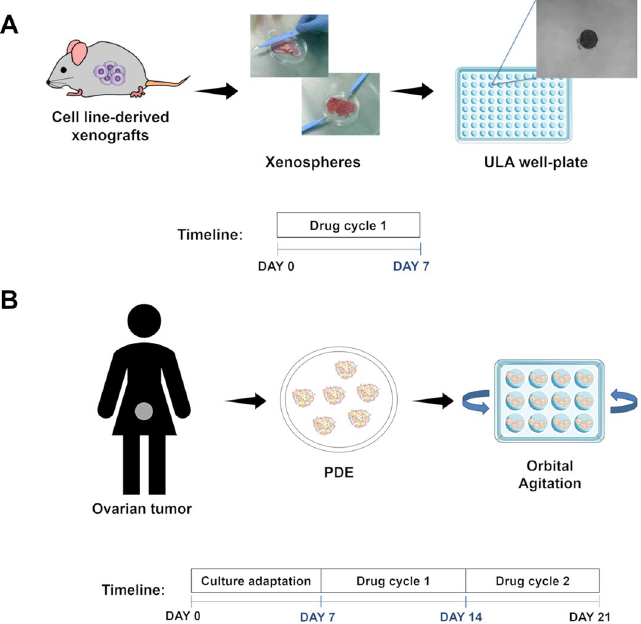
Figure 3. Schematic representation of the culture generation and drug cycle strategy pursued for ex vivo cultures. ( A ) Mouse xenografts are mechanically dissociated to form xenosphere explants. Individual xenospheres are cultured in a single well of a 96-well ultra-low attachment (ULA) plate. Docetaxel (DTX) treatments of 0.1, 5, 25, 125, 625, and 3125 nM are added directly to the xenospheres on the day of culture generation. Cell death in xenosphere cultures is assessed on day 7 by LDH assay. ( B ) Surgical-resected ovarian tumor specimens are mechanically dissociated into fragments, named patient-derived explants (PDE) and cultured in 12-well plates at a concentration of 5 PDE/ml, under orbital agitation at 100 rpm. After a 7-day adaptation to culture period, PDE cultures are challenged weekly with standard-of-care (SOC) chemotherapy, namely carboplatin (25 mg/ml) or paclitaxel (10 mg/ml) as single agents or in combination. Cell death is assessed longitudinally (day 7, 14, and 21 of culture) by LDH